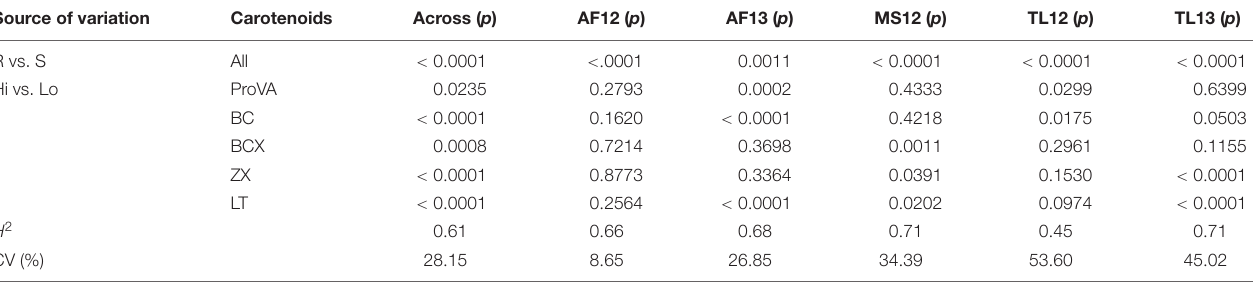
TABLE 2 | Probabilities of significance ( p ) for F -tests for contrasts of hybrids of aflatoxin resistant (R) vs. susceptible (S) testers, and for hybrids with high (Hi) vs. low (Lo) carotenoids concentrations for aflatoxin concentration in grain [AFTt, log(AFT + 1)] for analyses of variance at individual and across five trial environments. Source of variation